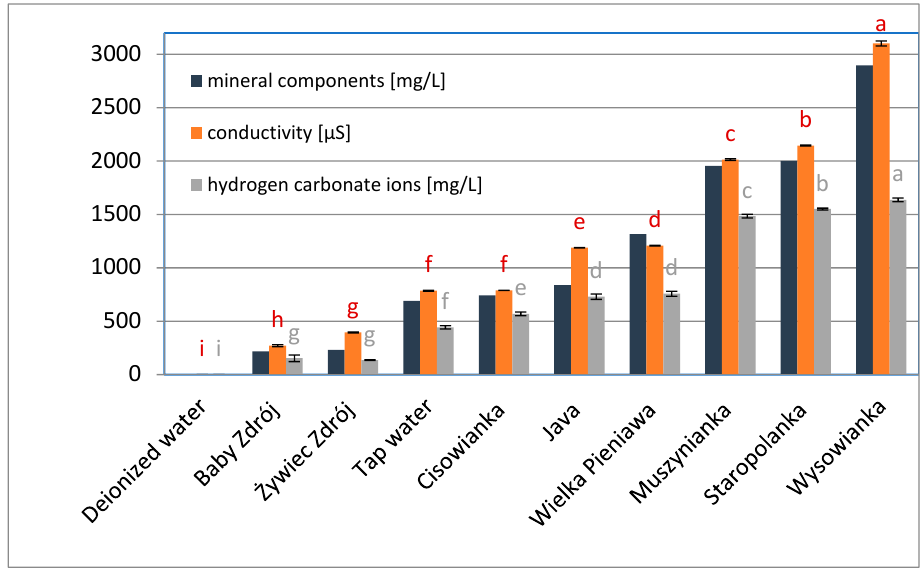
Figure 1. Conductivity, total content of mineral components and hydrogen carbonate ions in selected waters. Data are shown as mean ± SD. Different letters (a, b, c, etc.) show a significant difference with p < 0.05. The differences relate to each group of compounds